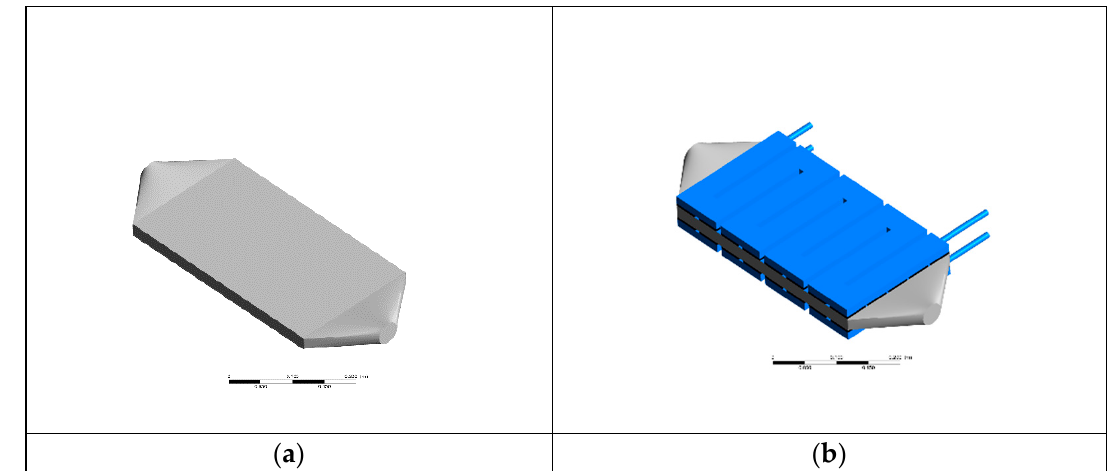
Figure 2. CFD simulation domain: ( a ) gas-side heat exchanger and ( b ) the whole TEG system.